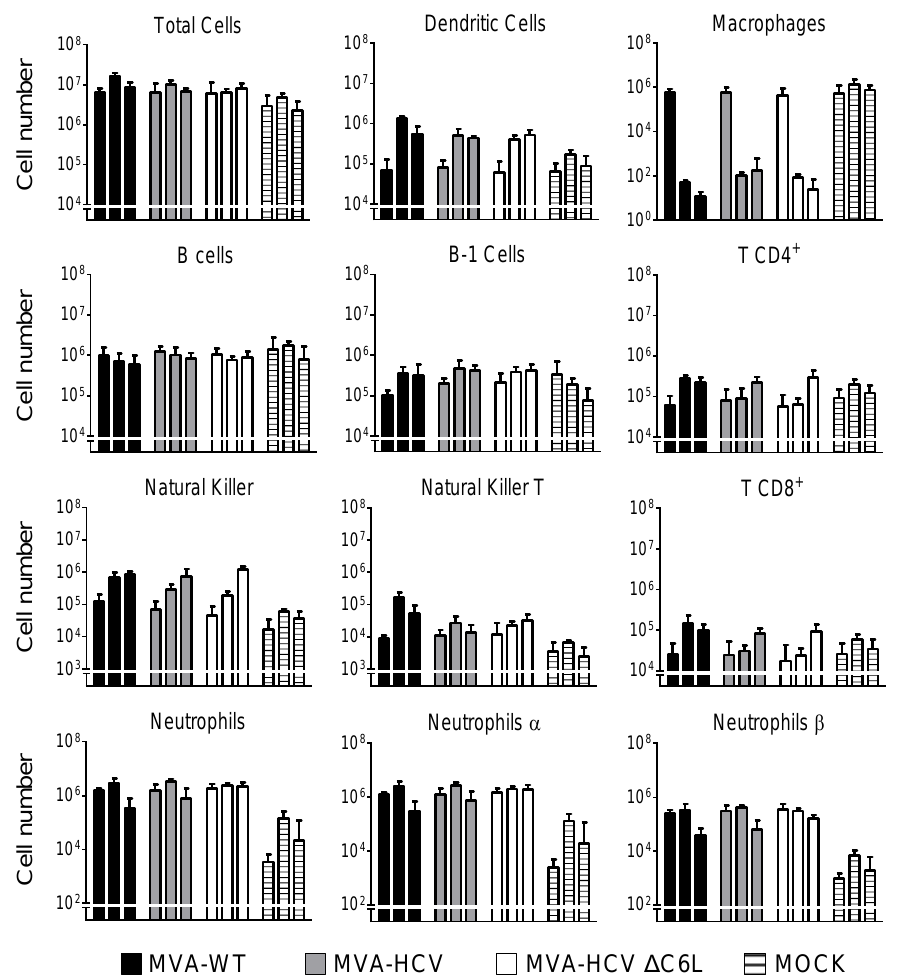
Figure 4. Recruitment of innate immune cells in the peritoneal cavity of infected mice. Absolute numbers of innate immune cell populations obtained from the peritoneal cavity of C57BL/6 mice infected by the i.p. route with MVA-WT, MVA-HCV, MVA-HCV ∆ C6L, or PBS. Peritoneal exudate cells were collected at 6, 24, and 48 h post inoculation (first, second, and third bar in each group, respectively) from each individual mouse ( n = 5 per group); stained for different surface markers; and absolute numbers analyzed by flow cytometry. Graphs show the logarithmic mean ± SD. Statistical significance of the comparison between MVA-HCV and MVA-HCV ∆ C6L was calculated with a two-way analysis of variance